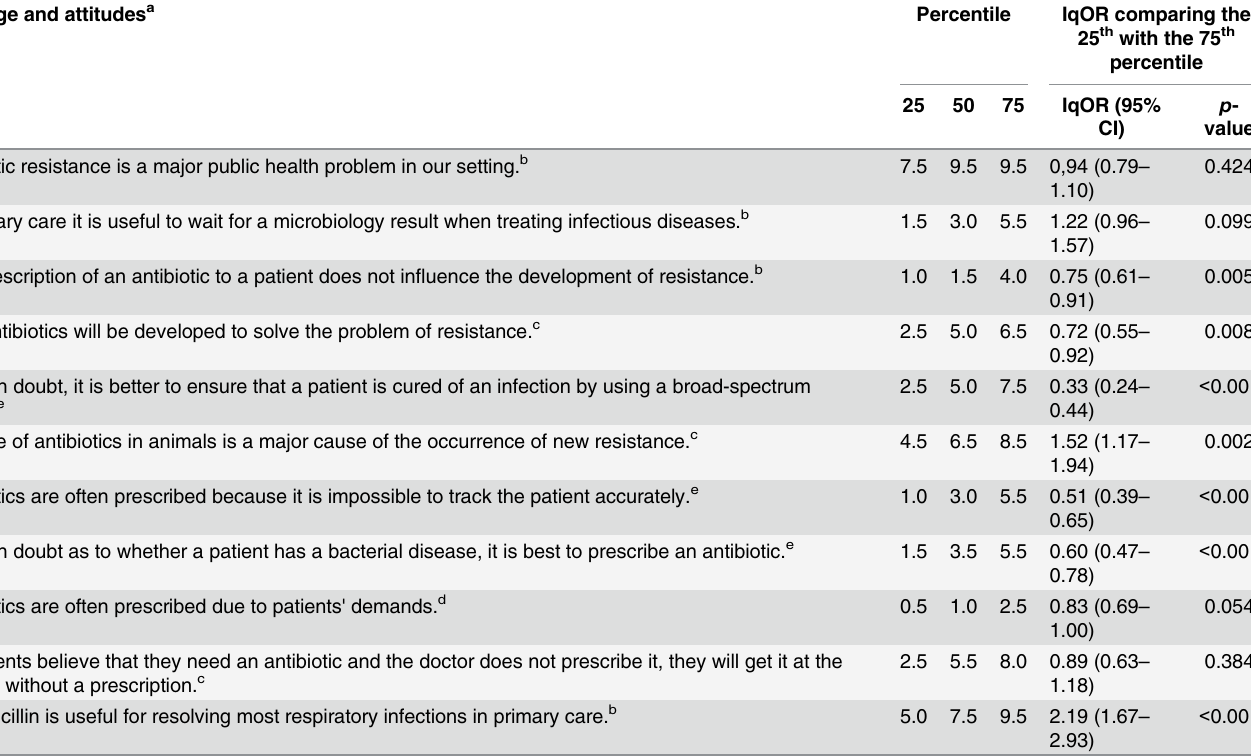
Table 1. Association between knowledge and attitudes, and antibiotic prescribing quality. OR of a physician displaying Appropriate Quality Prescrip- tion of Antibiotics (AQPA) versus not displaying AQPA, on comparing the 25 th with the 75 th percentile of each knowledge and attitude. Knowledge and attitudes